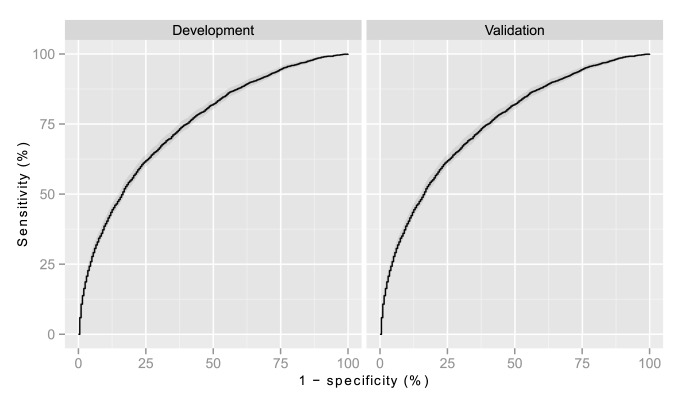
Receiver operator characteristic curve for development and validation cohorts.The ribbon represents the 95% CIs.